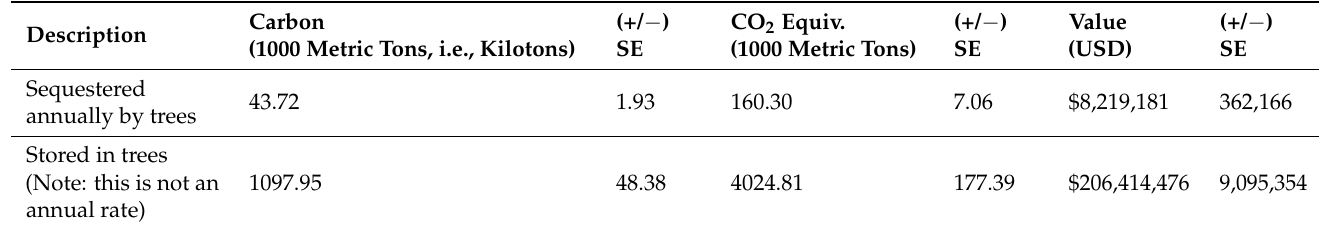
Table 2. Tree Benefit Estimates: Carbon (Metric units), Tbilisi, Georgia, 2022 (estimates, using random sampling statistics of i-Tree Canopy on 15 August